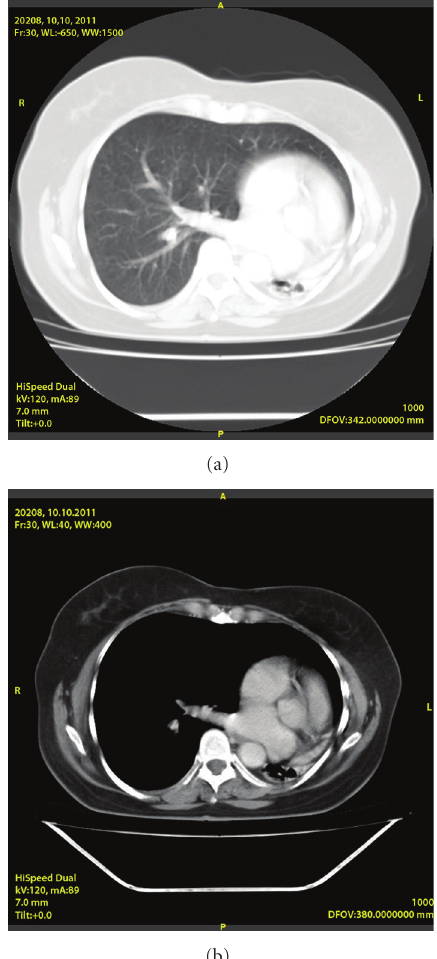
Figure 2: Thoracic CT scan revealing absence of left pulmonary artery and ipsilateral pulmonary